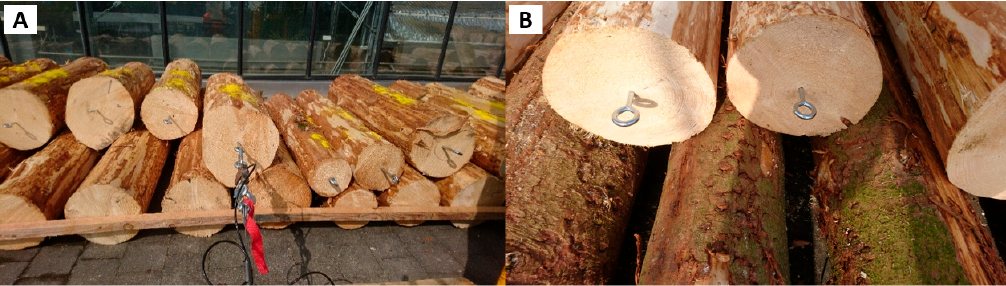
Figure 2. ( A ) Front display of the test setup and ( B ) open-eye hooks used for coupling to the measuring unit.